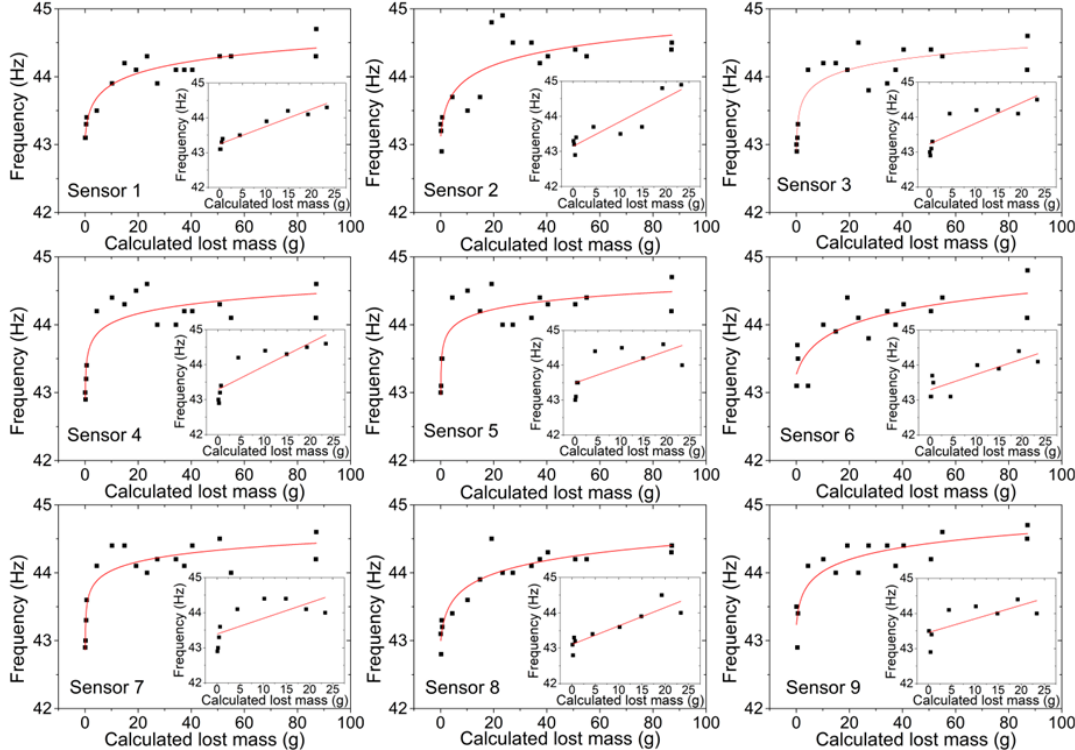
Figure 9. Relation between the calculated lost mass and the natural frequency of the plate obtained by each FBG sensor during the entire experiment. Inset images: Natural frequency variation as a function of the calculated lost mass for each FBG sensor during the initial 120 h.